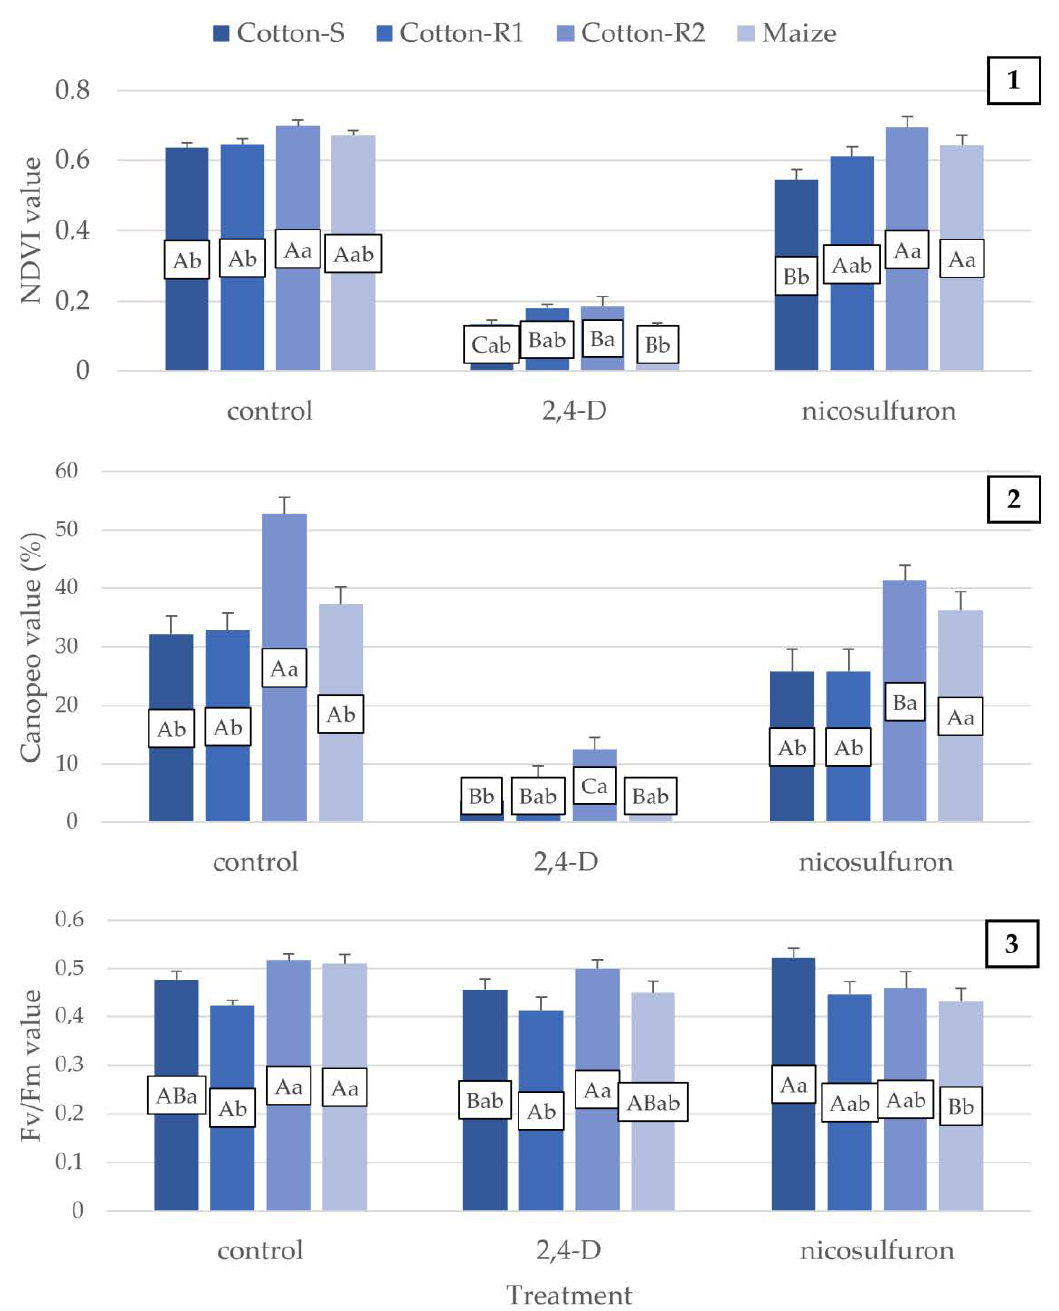
Figure 4. NDVI ( 1 ), Canopeo ( 2 ) and Fv/Fm ( 3 ) values 21 DAT for the three A. palmeri biotypes from cotton and the one from maize. Vertical bars indicate standard errors of the means. The different uppercase letters (A, B and C) indicate significant differences between the treatments in the same biotype. The different lowercase letters (a,b and c) indicate significant differences between the biotypes for a specific treatment. Both analyses carried out after the means separation, using Fisher’s least significant difference (LSD) test at p ≤